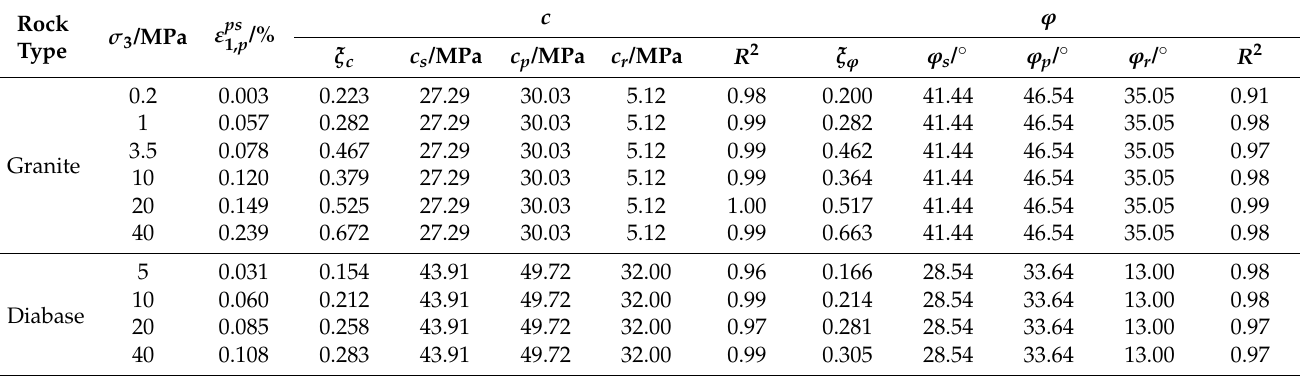
Table 3. Fit coefficients for cohesion/internal friction angle–axial plastic strain curves of two hard brittle rock types at different confining